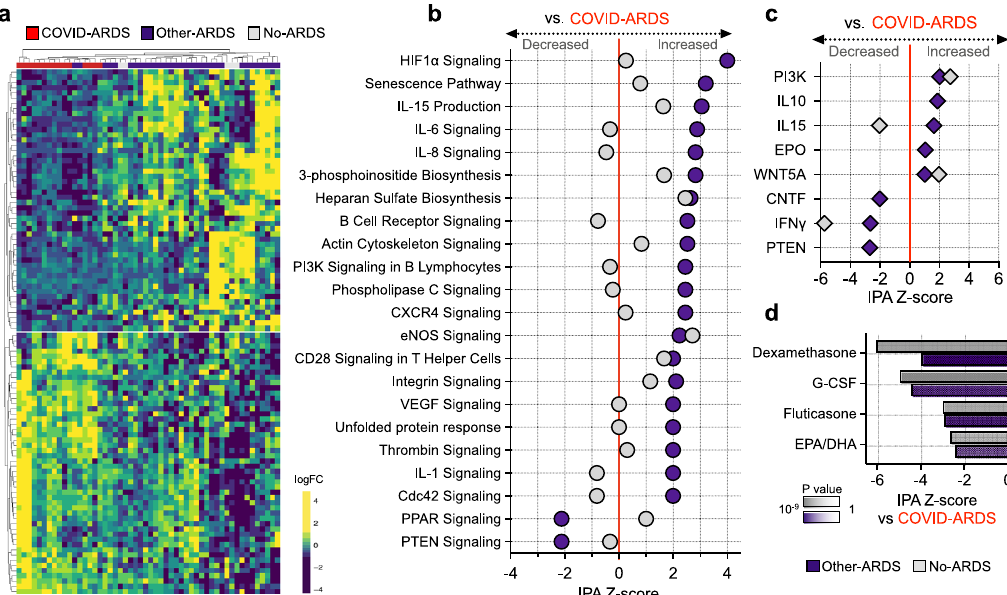
Fig. 1 Lower respiratory tract transcriptional signature of COVID-19 ARDS. a Heatmap of the top 50 differentially expressed genes by adjusted P value between patients with COVID-19-related ARDS (COVID-ARDS, red) versus controls with ARDS due to other etiologies (Other-ARDS, violet). Intubated controls with no ARDS were also included in the unsupervised clustering (No-ARDS, gray). b P IPA activation Z-scores for selected pathways in Other- ARDS and No-ARDS samples compared to COVID-ARDS samples. Values are tabulated in (Supplementary Fig. 3). c Predicted activation state of upstream cytokines, PTEN and PI3K in Other-ARDS and No-ARDS relative to COVID-ARDS patients. Values tabulated in Supplementary Fig. 4. d Pharmacologic agents predicted to mitigate the dysregulated host response of COVID-19 ARDS with respect to Other-ARDS (violet) or No-ARDS patients (gray) identi fi ed in the IPA database of drug transcriptional signatures. Values tabulated in Supplementary Fig. 5. Source data are provided in the Source Data fi le. P values were calculated using a one-sided Fisher ’ s exact test. G-CSF granulocyte colony-stimulating factor, EPA eicosapentanoic acid, DHA docosahexanoic